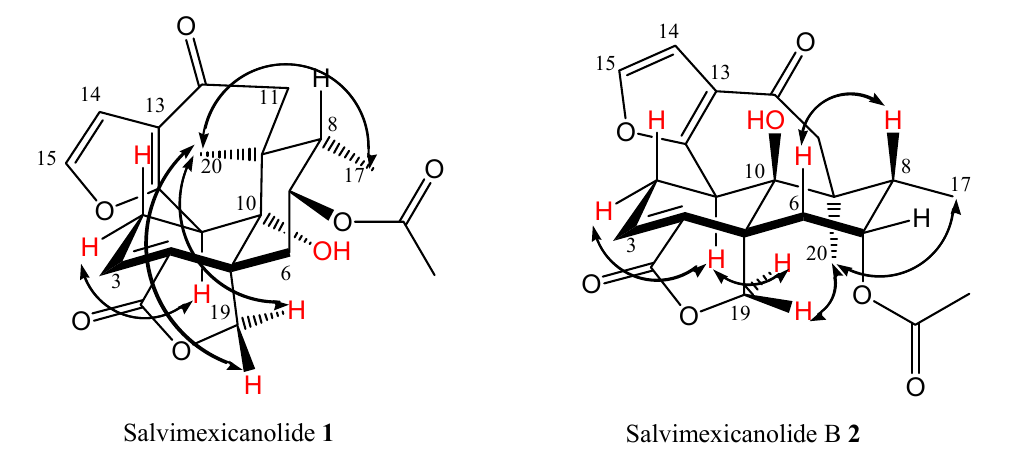
Figure 2. Key NOESY